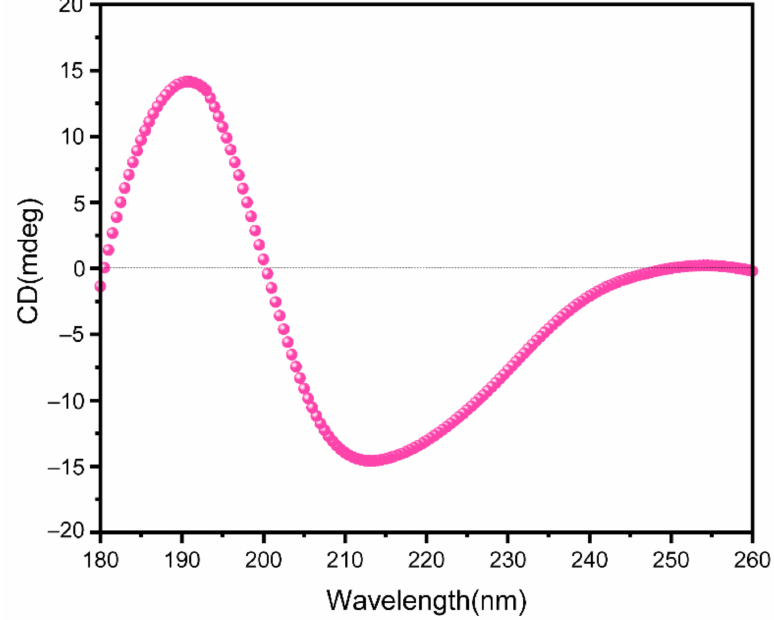
Figure 3. Circular dichroic analysis of DRF3.